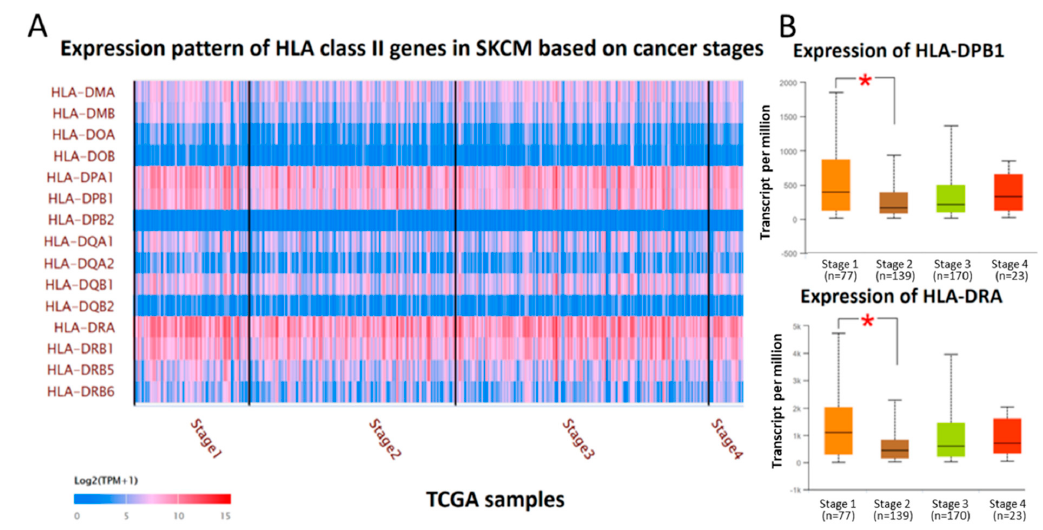
Figure 2. ( A ) The expression pattern of 15 HLA class II genes in each stage of cutaneous melanoma was displayed as heatmap in log 2 (TPM + 1) scale. ( B ) The box plot represented expression of HLA-DPB1 and HLA-DRA in di ff erent stages of cutaneous melanoma from TCGA samples. Significant di ff erence ( p < 0.05) in expressions was detected between Stage 1 and Stage 2, but not between other cancer